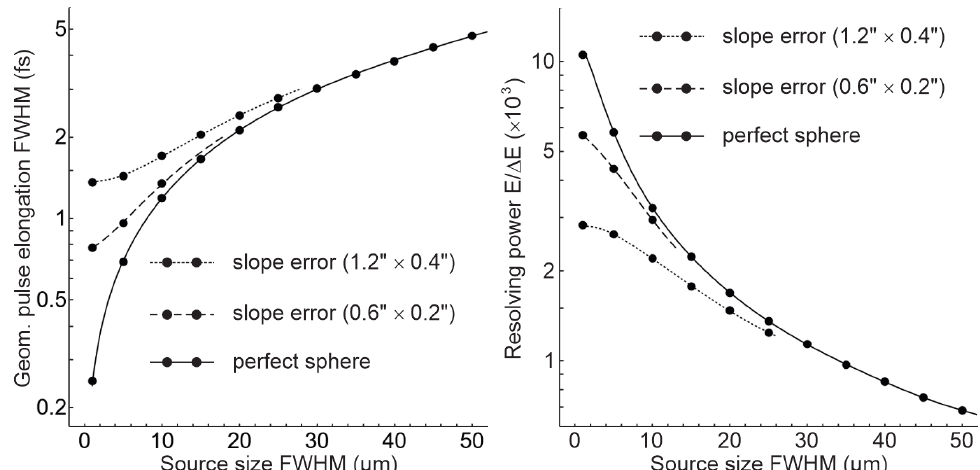
Figure 3. Geometrical pulse elongation τ geo in the sample plane ( left ) and resolving power E / ∆ E ( right ) at the design energy E 0 (Table 2) vs. source size for various slope errors (mer. × sag.) on the RZPs. In the right plot, the diffraction limit for ∆ ϑ = 1mrad is taken into account via convolution with RT data (black dots). Continuous lines are drawn as a guide for the eyes. Toward large source diameters, the curves coincide asymptotically and overlapping data points are omitted for